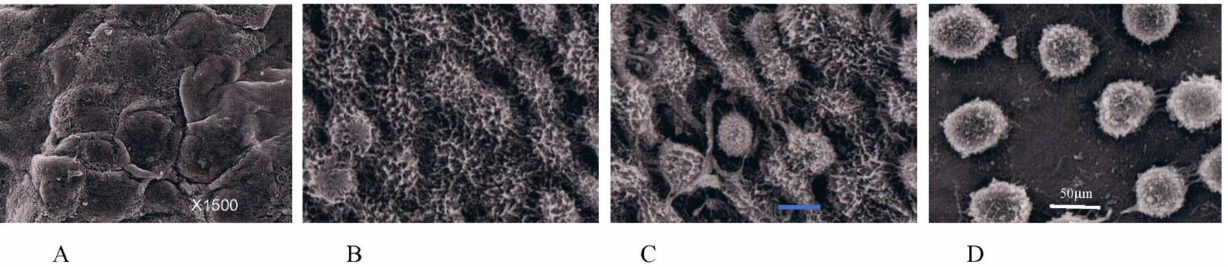
Figure 14. Morphological changes in mesothelial cells. ( A ) Normal mesothelial cells are flat and cuboidal in shape and attach to each other without inter-cellular gap. ( B ) Mesothelial cells activated by PFCCs show shrinkage and have well-developed microvilli. ( C ) The mesothelial cells separate from each other, exposing basement membrane as peritoneal metastasis progresses. ( D ) Finally, as mesothelial cells become round in shape, the submesothelial basement membrane becomes widely exposed.